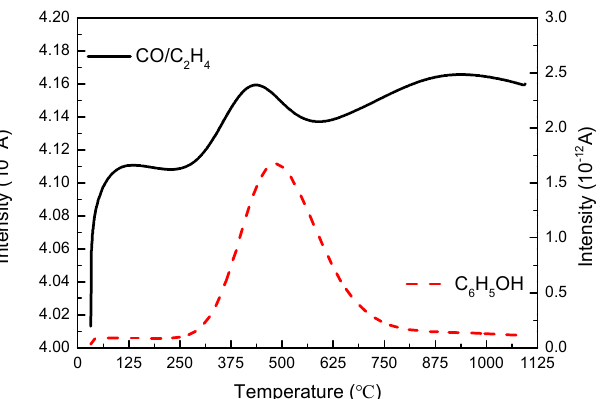
Figure 10. Intensity curves of m / z = 28 and 94 degradation products of composite released during TGA (20 °C/min-inert gas).